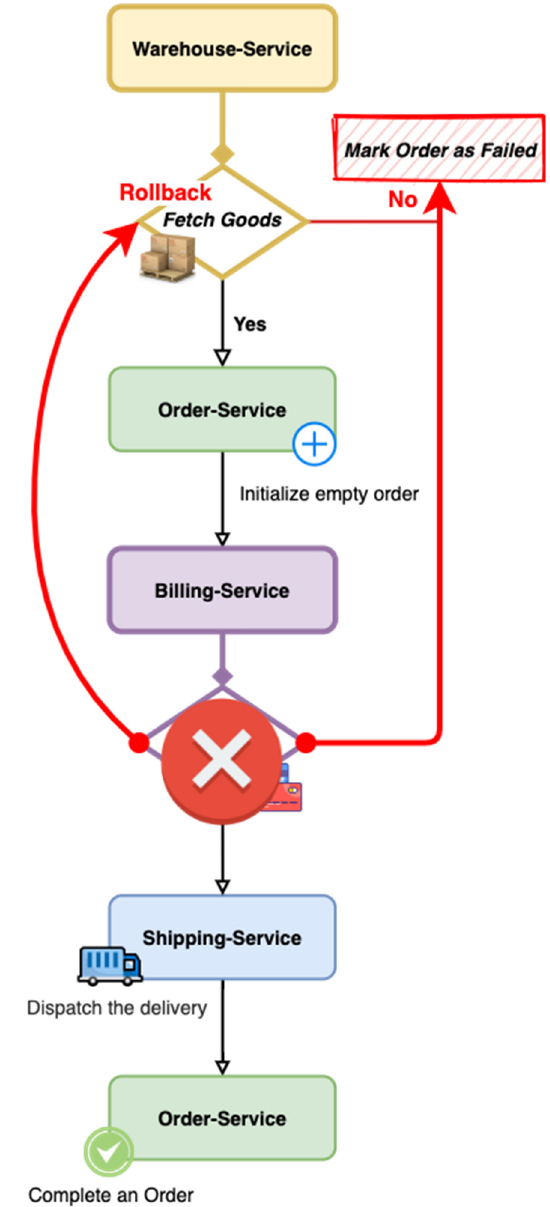
Figure 10. The event workflow of the application with a payment error scenario.